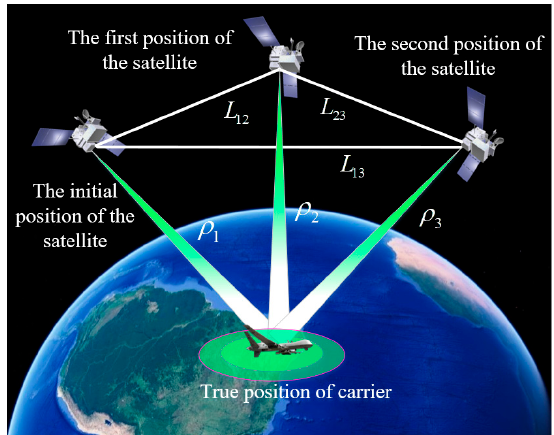
Figure 1. Schematic diagram of single-satellite positioning.